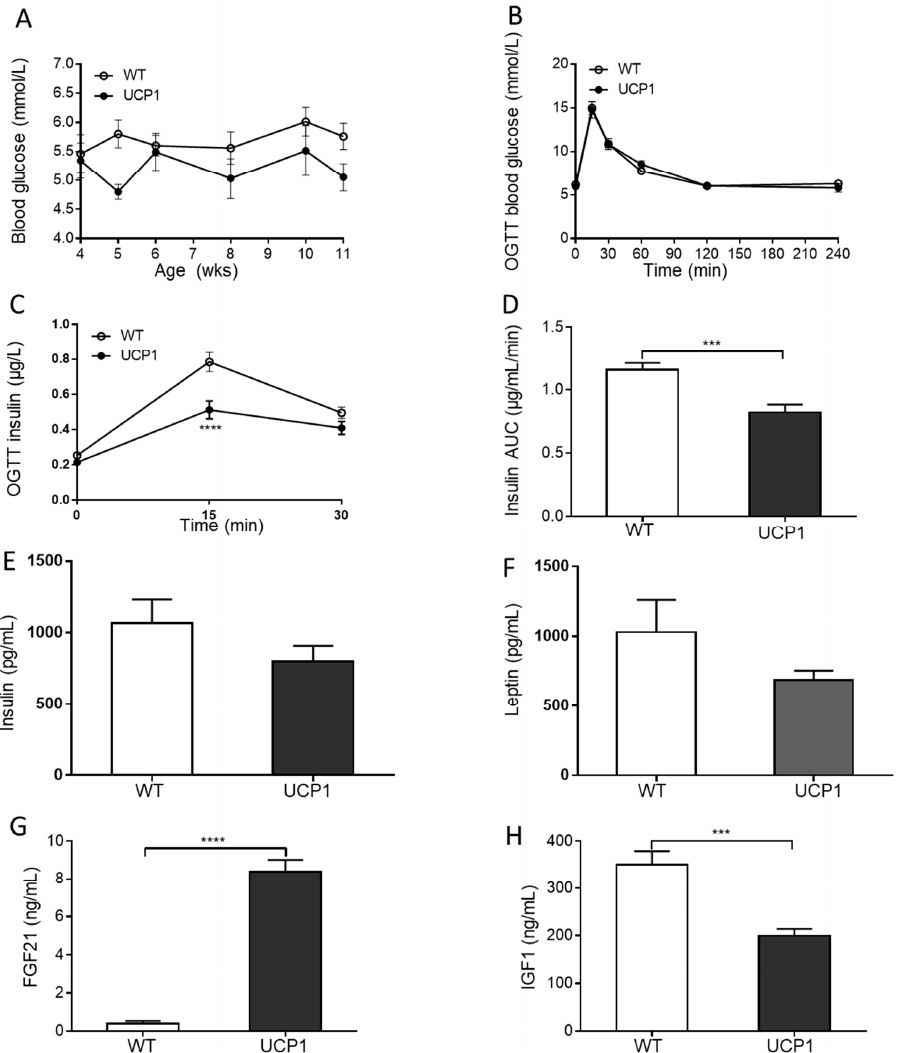
Figure 3. Metabolic health related parameters of UCP1-TG (UCP1) and WT mice. Blood glucose levels from the age of 4 until 11 weeks ( A ), glucose response to an oral glucose tolerance test (OGTT) at the age of 10 weeks ( B ), insulin response to the OGTT at the age of 10 weeks ( C ), incremental area under the curve (AUC) of the insulin response to the OGTT ( D ), plasma insulin concentrations (pg/mL) ( E ), plasma leptin concentrations (pg/mL) ( F ), plasma fibroblast growth factor 21 (FGF21) concentrations (ng/mL) ( G ) and plasma insulin-like growth factor 1 (IGF1) concentrations (ng/mL) ( H ). Data are expressed as mean +/ − SEM ( n = 10); ( A – C ): two-way ANOVA; ( D – H ): Student’s t-test, *** p < 0.001, **** p < 0.0001.